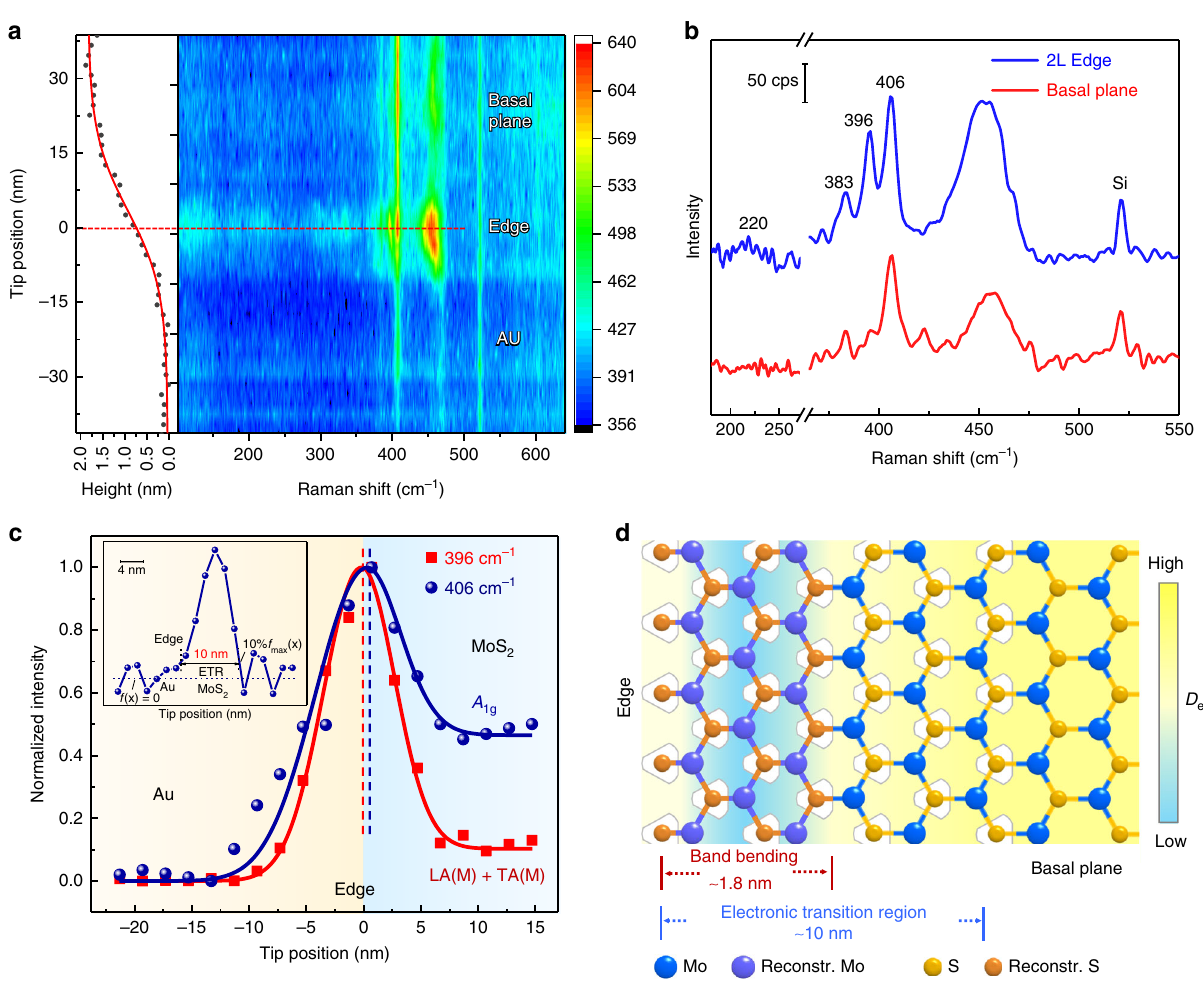
Fig. 3 TERS characterization of a bilayer edge in MoS 2 . a TERS line image across the edge of a bilayer MoS 2 . Left panel: topographic height pro fi le of the edge of bilayer MoS 2 marked in Supplementary Fig. 16b inset. Right panel: a line-trace TERS image of the edge. Note that these are original TERS experimental spectra without any processing. See Supplementary Fig. 16a for more data sets for the corresponding line-trace TERS spectra. b Two typical TERS spectra of a bilayer MoS 2 at the basal plane and the edge. c Plots of normalized intensities of two TERS peaks (396 and 406 cm − 1 ) with the tip position. The solid lines are the fi tted results. Note that these spectra are the pure near- fi eld signals and have been subtracted with the far- fi eld signals. Inset is the enhanced TERS intensity pro fi le of the ETR in the 2 L edge after the deconvolution of the EM fi eld the intensity distribution (see Supplementary Note 2 for more details). d Schematic diagram of band reconstruction and ETR of MoS 2 near the edge. D e is the electron